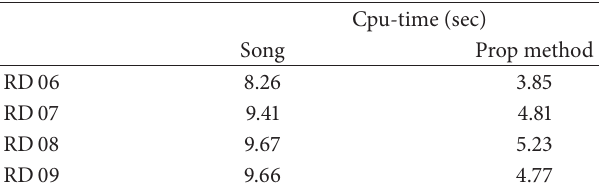
Table 2: Evaluation of cpu-time